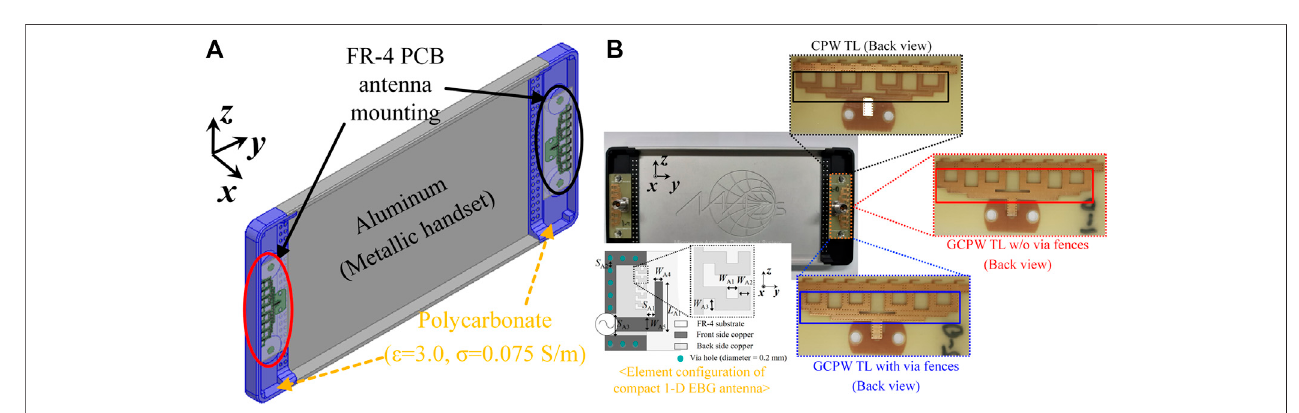
FIGURE 4 | Phased arrays for mm-Wave mobile device. (A) 3-D Perspective view. (B) Photograph of the mm-Wave mobile device with various feeding networks( Antennaelement: 1-DEBGantenna(2.1 mm × 3.6 mm),DetailedDimensions: W A1 (cid:2) 0.1 mm,W A2 (cid:2) 0.1 mm,W A3 (cid:2) 0.1 mm,W A4 (cid:2) 0.3 mm,W A5 (cid:2) 0.5 mm, L A1 (cid:2) 1.8 mm, S A1 (cid:2) 0.3 mm, S A2 (cid:2) 0.25 mm, S A3 (cid:2) 0.8 mm